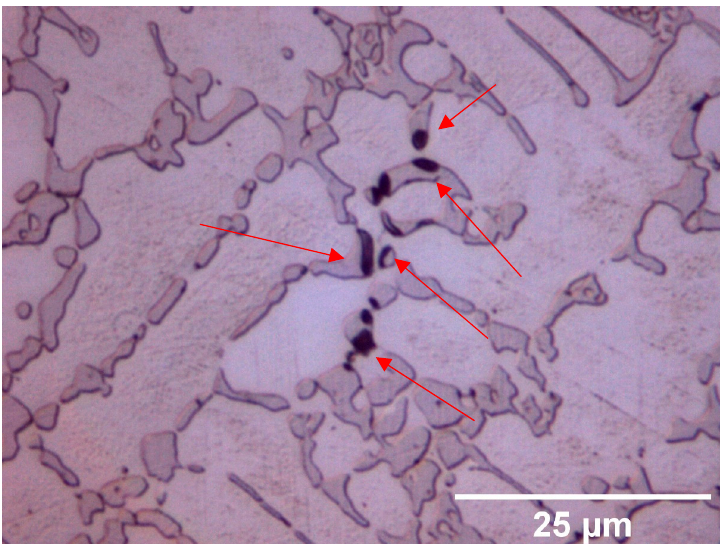
Figure 7. Optical microscope image of 100/0 nickel-rich deposit taken by using Nomarski interference contrast. The elevated inter-dendritic phase is nickel boride, whereas the dendritic phase is the nickel phase. The dark-phase particles (annotated by the red arrows) are suspected to be silica inclusions.